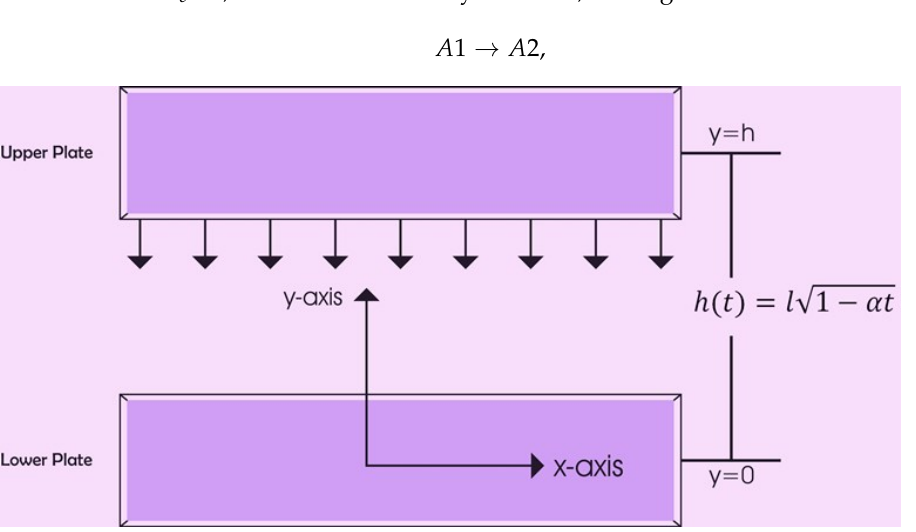
Figure 1. Geometry of the